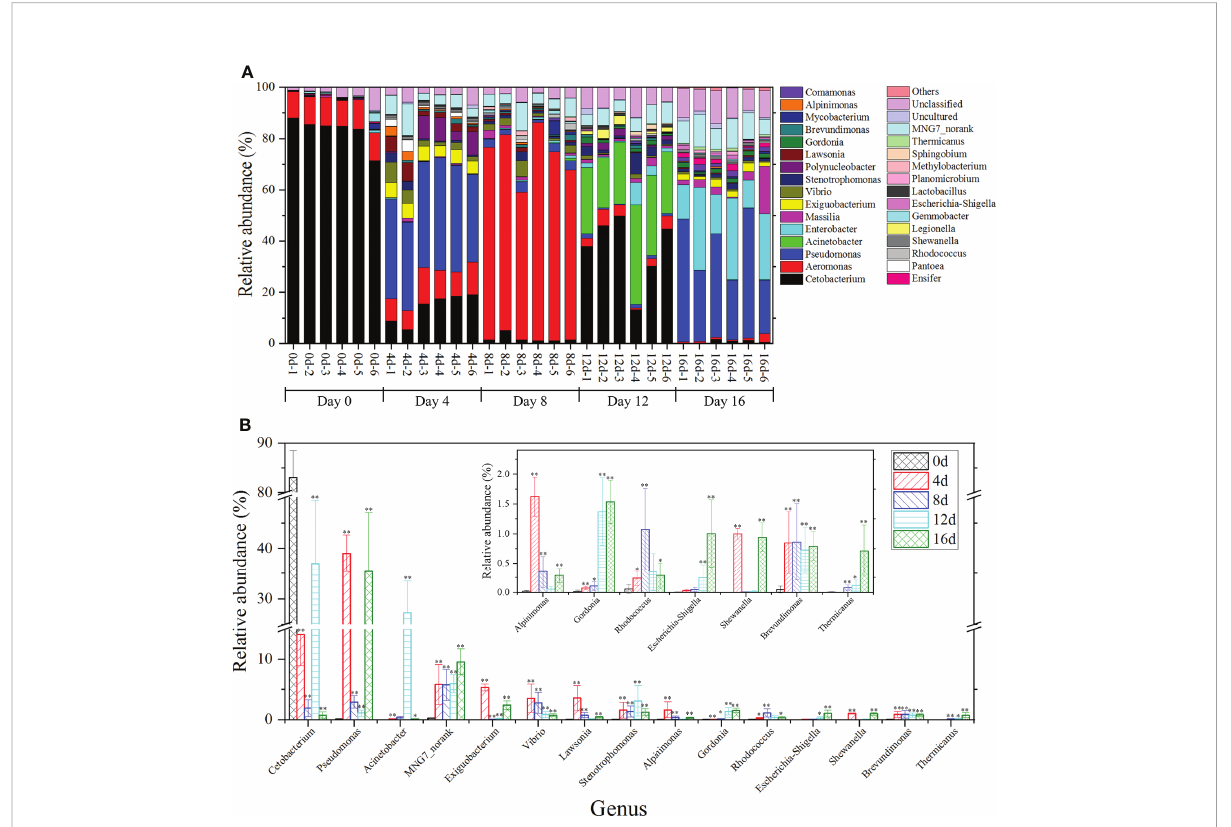
FIGURE 6 The in fl uences of short-term exercise on microbial genera in this hybrid species. The relative richness of prominent bacterial genera in the gut of this hybrid species during swimming at diverse durations (A) . Richness differences in microbial taxa among different durations of swimming exercise groups at the genus level (B) . * P ≤ 0.05, ** P ≤ 0.01. Data were provided as mean ±